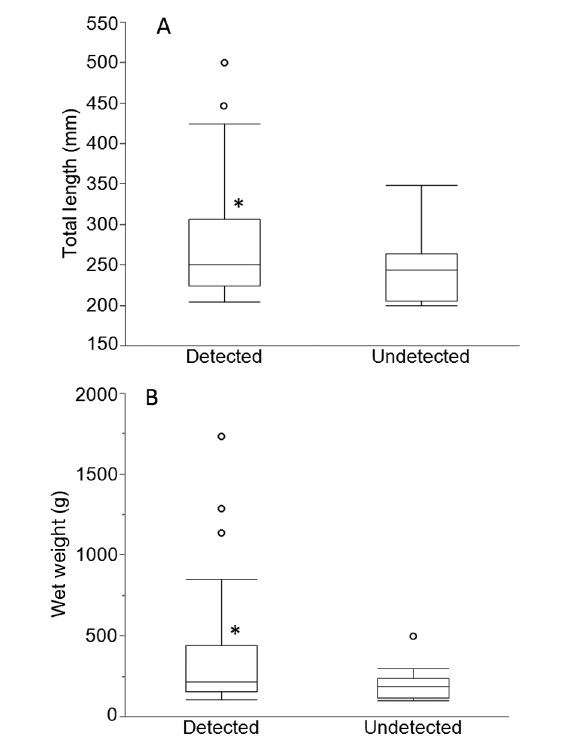
Fig. 4. (A) Total length and (B) wet weight of acoustically detected and non-detected tagged seabream between May 2017 and October 2018. Box plots parameters: line through the box: median; lower and upper boundaries: 25 th and the 75 th percentiles. The middle half of the data is within the box; the majority of the data falls between the ends of the whiskers. Data points outside the whiskers: potential outliers. Asterisk: significant difference between means (Wilcoxon-Mann-Whitney test, p <